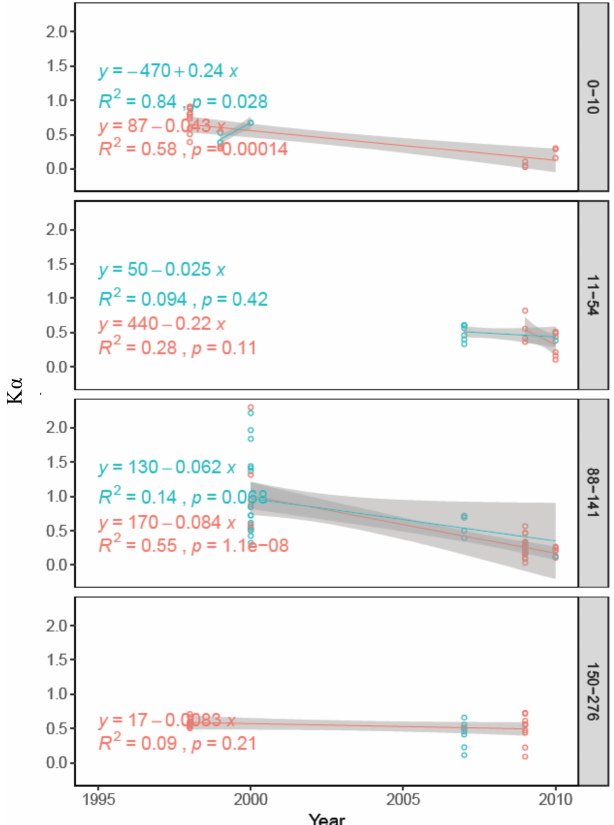
Figure A4. Permafrost sensitivity criterion (K α ) in July (blue open circles and linear regression lines) and August (red open circles and linear regression lines) at wildfire-affected sites of different ages in the 1995–2010 study period. Grey areas represent standard errors. The figure in the grey bar at the right side indicates the age interval of larch